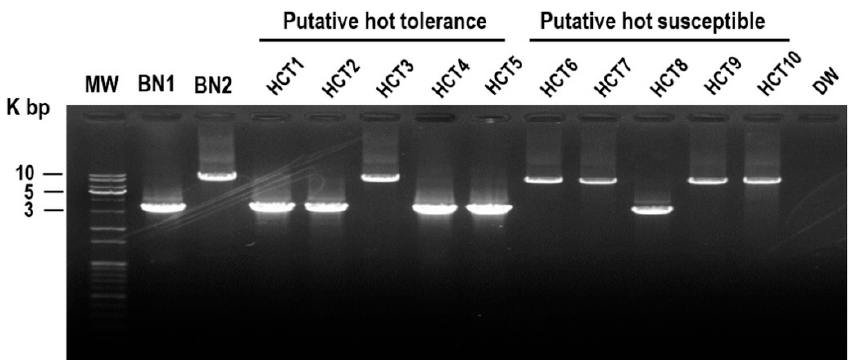
Figure 5. Validation of two BoTPPI-2 alleles (BN1-type and BN2-type) in cabbage inbred lines by PCR using the BoTTI-2-F / -R primer pair. Putative high temperature (HT)-tolerant lines (HCT1–5) and HT-susceptible lines (HCT6–10) were provided by Joen Seed Co., Korea.